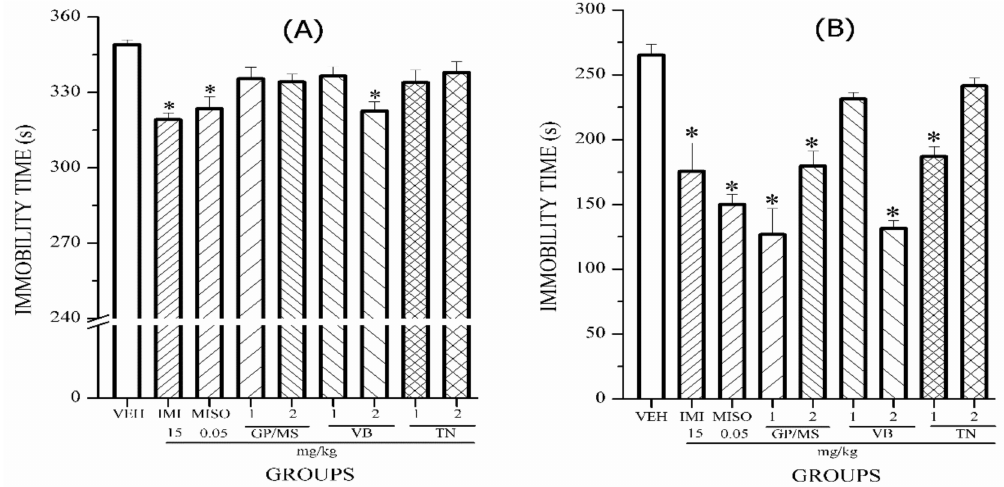
Figure 6. Effect of oral administration of the compounds geniposide/mussaenoside ( GP / MS ), verbascoside ( VB ) and tenuifloroside ( TN ) at 1 and 2 mg/kg on immobility time of ICR mice exposed to TST ( A ) and FST ( B ). ANOVA followed by post hoc Bonferroni test (mean ± SEM) * p ≤ 0.05, compared to the VEH control